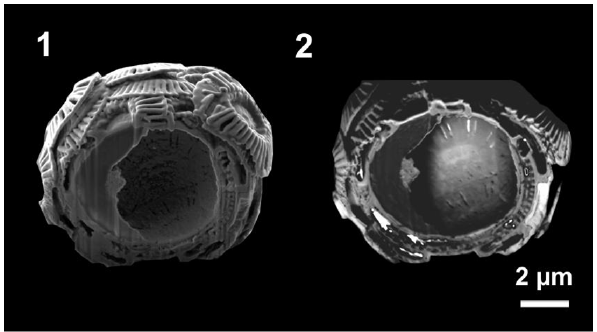
Figure 5. SEM images of the same coccosphere cross section taken using secondary electrons (1) and backscattered electrons (2). Secondary electrons are generated closer to the surface, so image 1 shows a lot more of the finer surface features. Backscattered electrons are sensitive to chemical composition, and are generated deeper in the